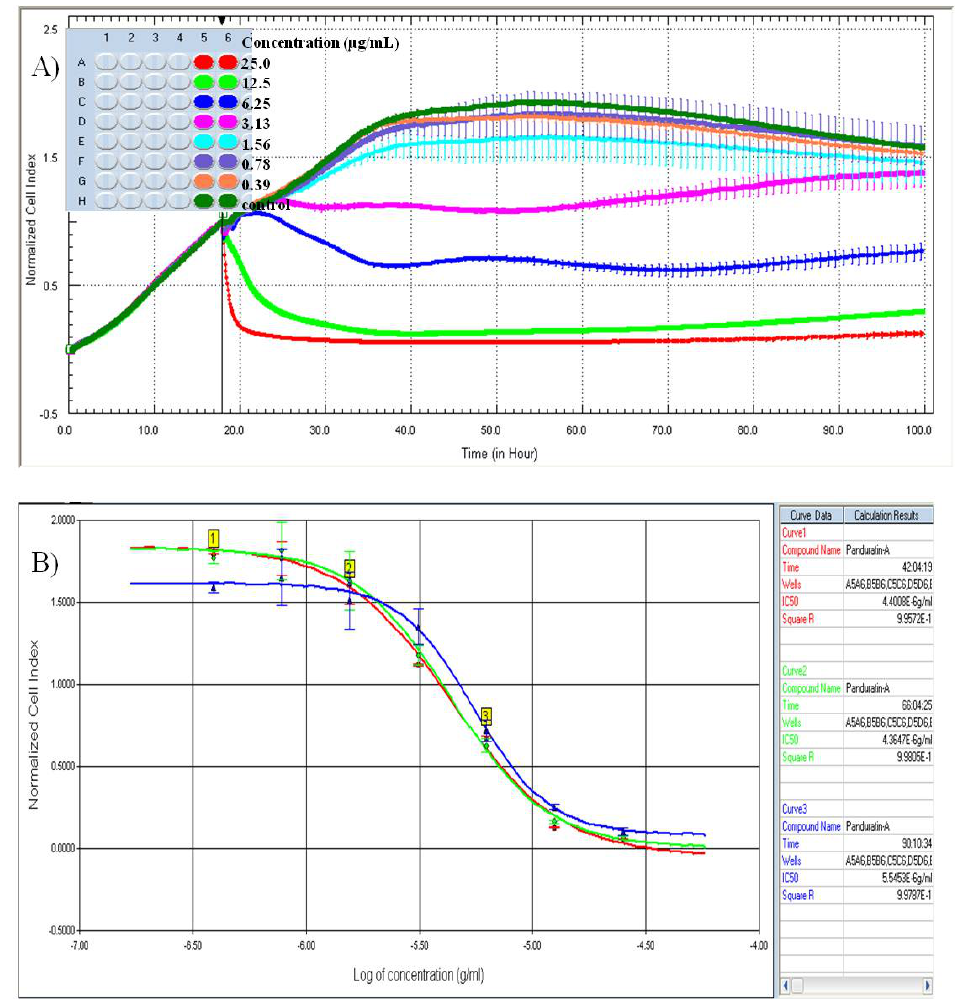
Figure 2. (A) Dynamic monitoring of drug interaction with target cells using the RTCA. A549 cells were seeded in 16X E-plate device were continuously monitored up to 100 hours at which point panduratin A were added at the indicated final concentrations. CI values were normalized to the time point of compound addition, indicated by the vertical black line. (B) IC value in RTCA system after 24, 48 and 72 hours treatment of 50 panduratin